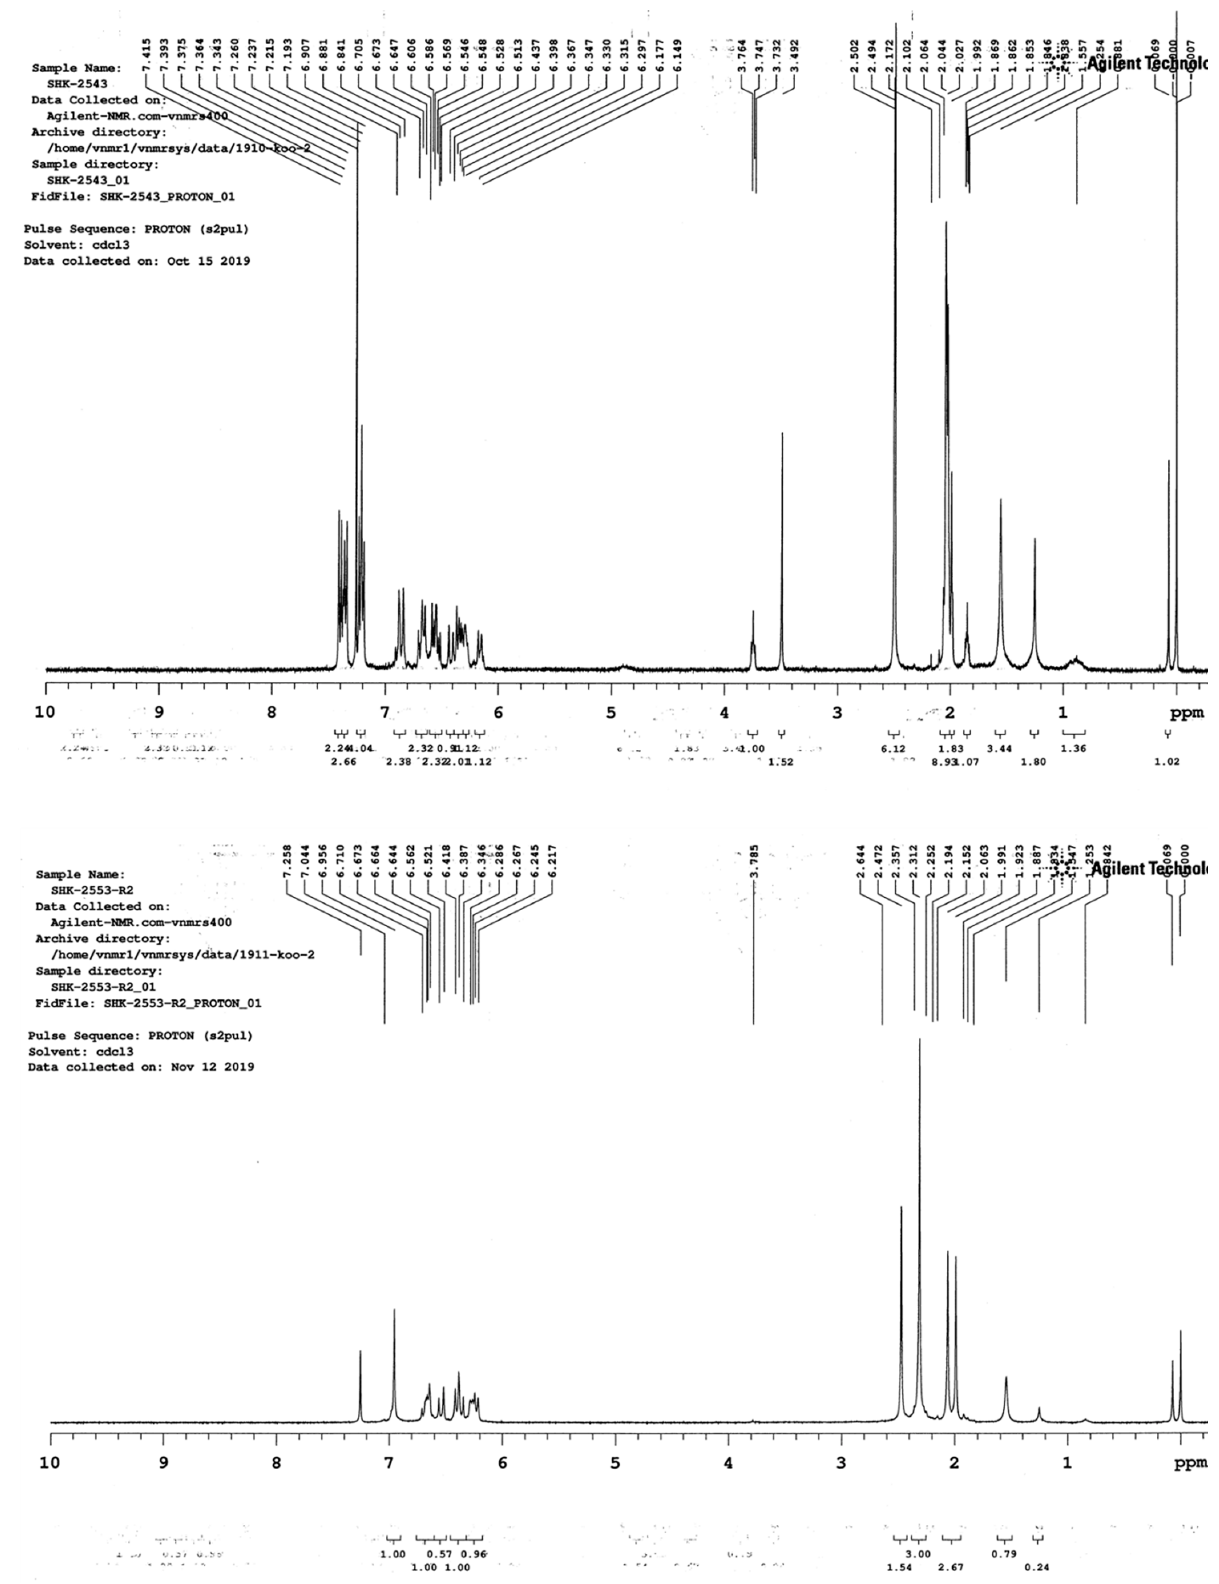
Figure A7. 1 H nuclear magnetic resonance (NMR) spectrum for cis -TMC-syn (top) and for trans-TMC (bottom).